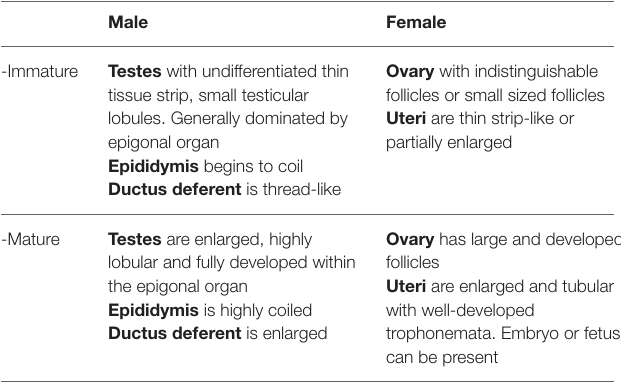
TABLE 1 | Criteria used to determine the internal maturity stage of the Mobulidae, adapted from Braccini et al. (2006) and ICES (2013).